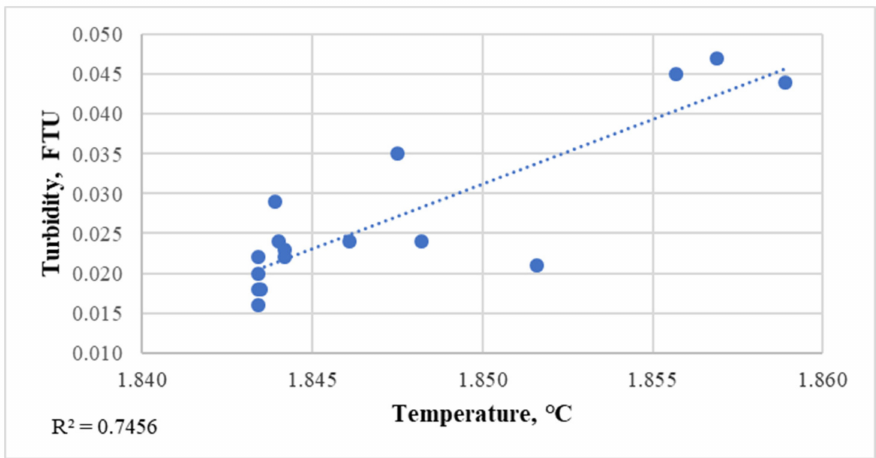
Figure 6. Turbidity/temperature regression line for the bottom water layer at a depth of 2835–2850 m. Source: Irina 1, Logachev